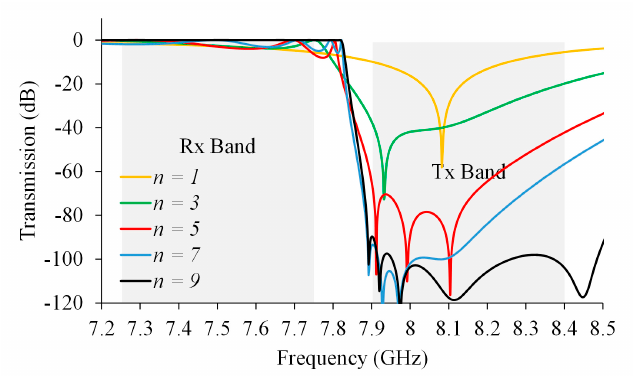
Figure 7. Simulated transmission | S 21 | variation as a function of the number of filter sections. Table 1. Rx band filter dimensions.